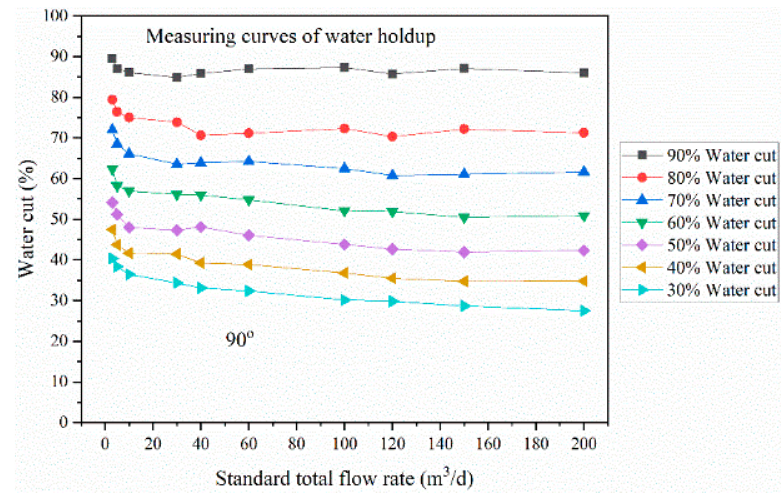
Figure 9. Water holdup measurement chart (inclination angle 90°).